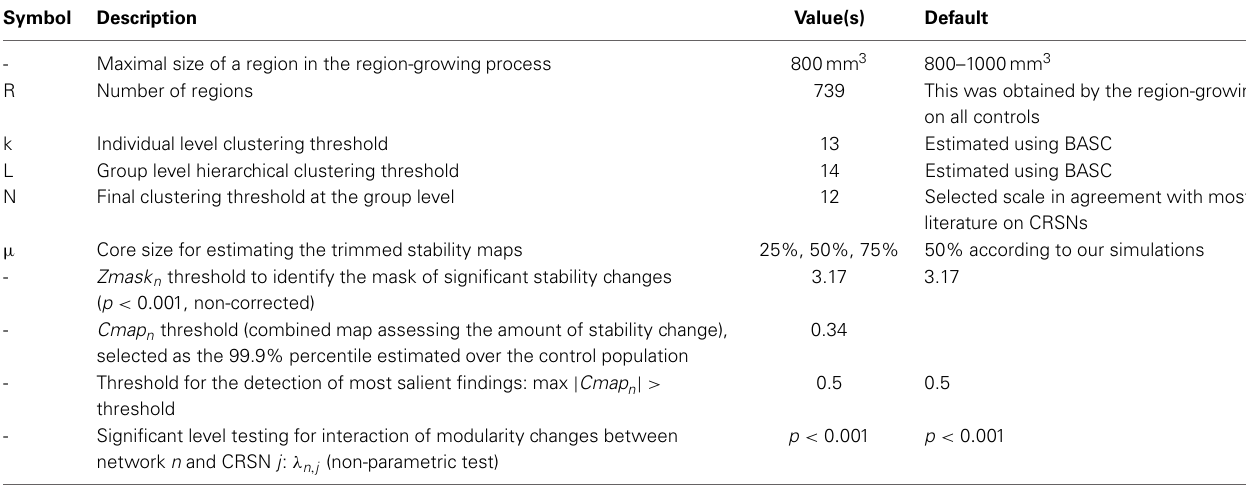
Table 3 | Parameters used in the